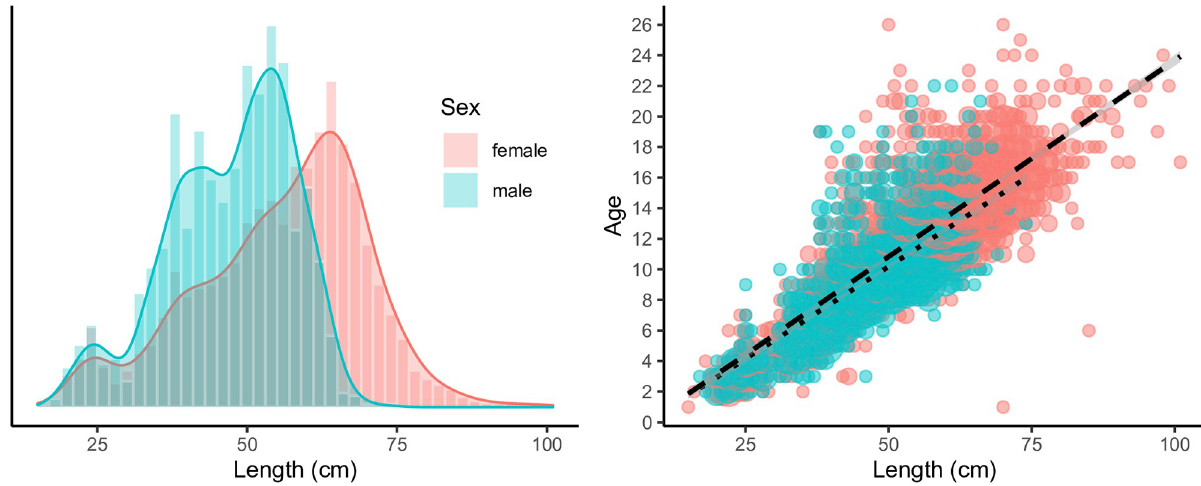
Fig 4. Age versus length. Left: Length distribution for the dataset. As for age, the female distribution has a larger mean as well as a larger variance than the male distribution. Right: A scatter plot of the labeled age against the measured length. The two dotted lines shows a fitted regression line for each